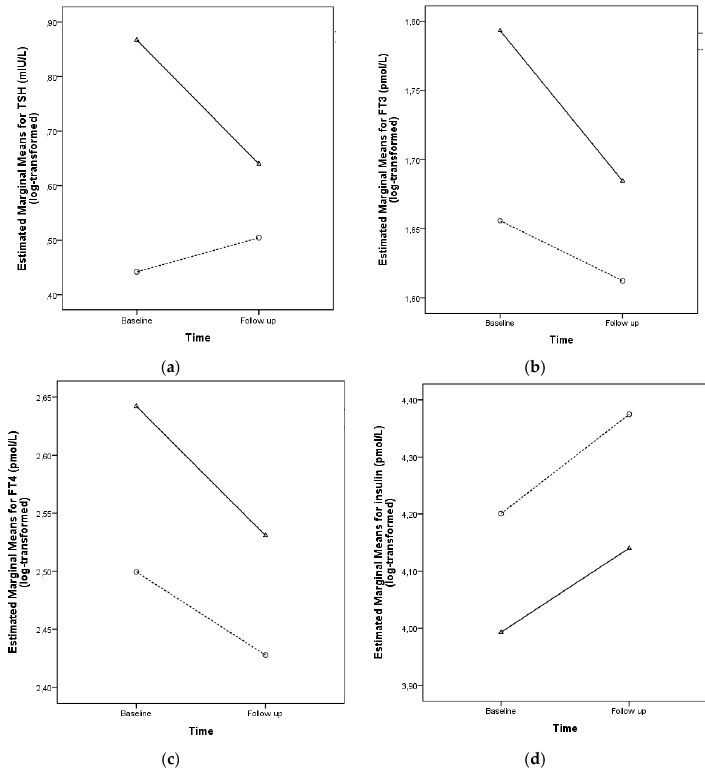
Figure 3. TSH, FT3, FT4, and insulin concentrations at baseline and follow-up after 16 months of treatment. Continuous line indicates Treatment 1, dashed line depicts Treatment 2. Mixed between– within-subject ANCOVA adjusted for age and sex. (a) TSH, main effect for time: Wilks’ λ = 0.986, F 1138 = 2.03, p = 0.156; Interaction between time and group: Wilks’ λ = 0.919, F 1138 = 12.18, p = 0.001; group factor: F = 13.62, p < 0.001. (b) FT3, main effect for time: Wilks’ λ = 1.000, F 1137 = 0.005, p = 0.943; interaction between time and group: Wilks’ λ = 0.963, F 1137 = 5.32, p = 0.023; group factor: F = 34.90, p < 0.001. (c) FT4, main effect for time: Wilks’ λ = 0.996, F 1137 = 0.504, p = 0.479; interaction between time and group: Wilks’ λ = 0.980, F 1137 = 2.73, p = 0.100; group factor: F = 39.68, p < 0.001. (d) Insulin, main effect for time: Wilks’ λ = 0.997, F 1139 = 0.435, p = 0.511; interaction between time and group: Wilks’ λ = 0.999, F 1139 = 0.09, p = 0.762; group factor: F = 9.57, p = 0.002.